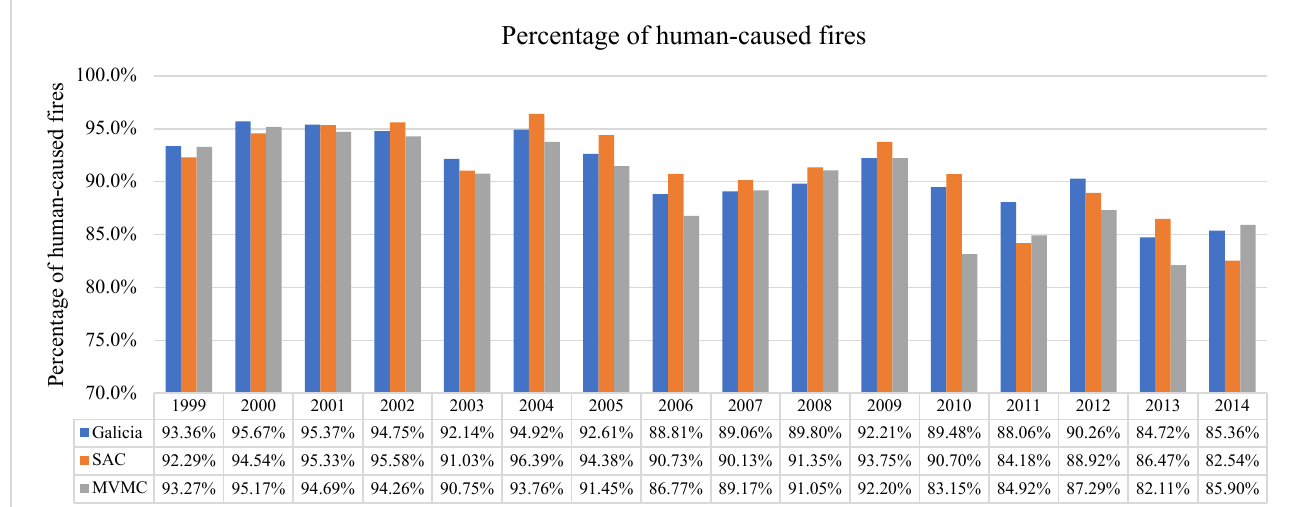
Figure 9. Percentage of human-caused fires in the territorial units of study for the period 1999–2014. Human-caused forest fires are those where the cause is coded as unknown, negligence or arson.